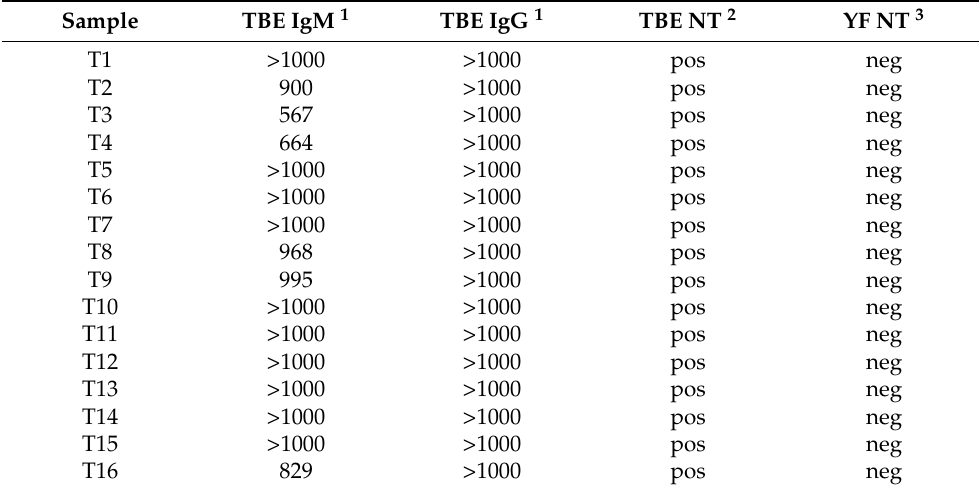
Table 2. Characteristics of serum samples obtained from tick-borne encephalitis (TBE) patients in Austria, 2017, as determined by routine serodiagnosis.